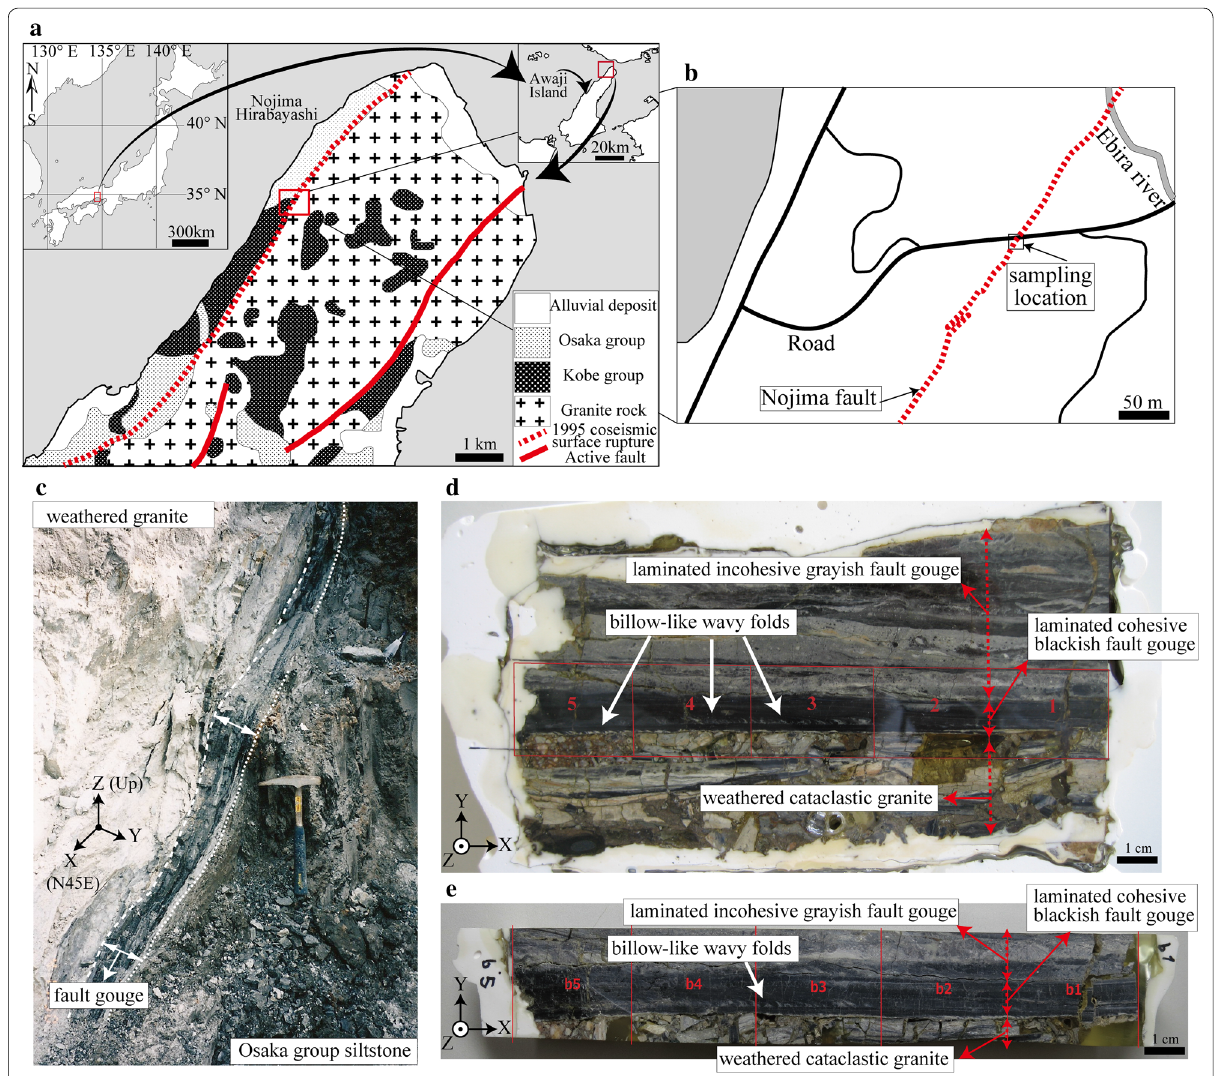
Fig. 1 a Location of Awaji Island, Japan, showing active faults and geology in the Kobe–Osaka area, modified after Lin et al. (2015) and Murakami et al. (2002). b Nojima fault gouge sampling location, modified after Otsuki et al. (2003). c Outcrop of the Nojima fault gouge. The fault gouge is observed between the weathered granite and the Osaka group siltstone, with dashed and dotted white lines indicating its upper and lower bounda- ries, respectively. The fault slip zone strikes N45°E, and dips 80° to the southeast. The X -axis indicates the strike and the Z -axis indicates up. The same X – Y – Z coordinate system is used in Figs. 1d, e, 2a, b, 6, and Additional file 1: S2. d Macroscopic photograph of the fault gouge sample used for scan- ning magneto-impedance (MI) magnetic microscope observation. Block samples used for making a thin section are indicated by red numbering . Billow-like wavy folds are observed within the laminated cohesive blackish gouge and also in between weathered granite and blackish gouge.